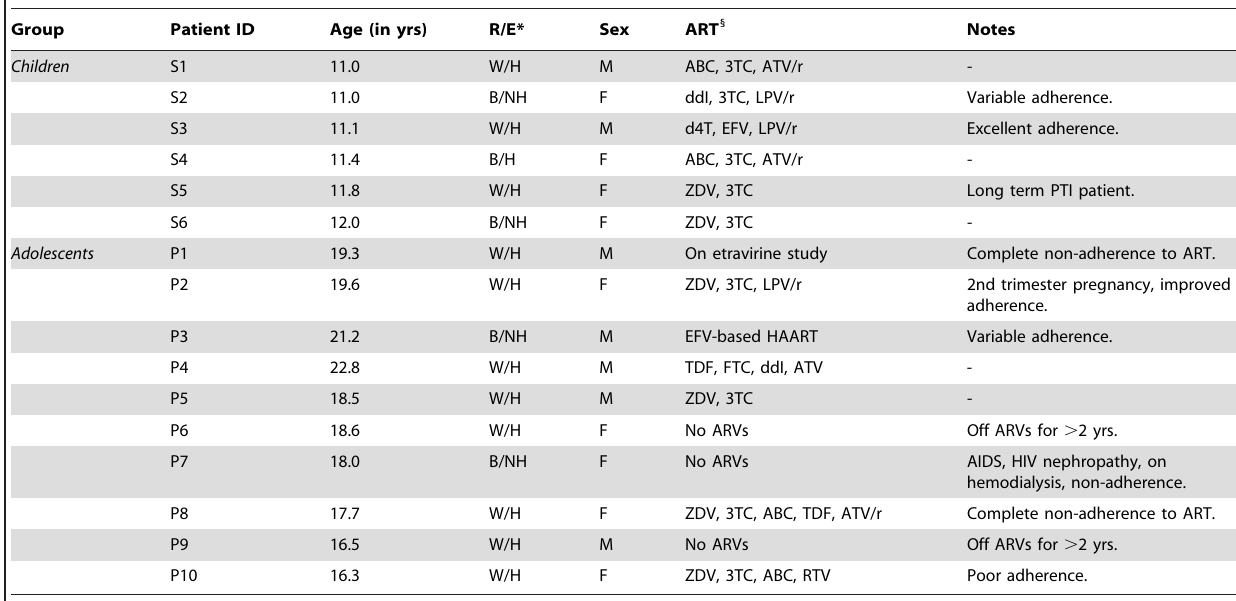
Table 2. Subject